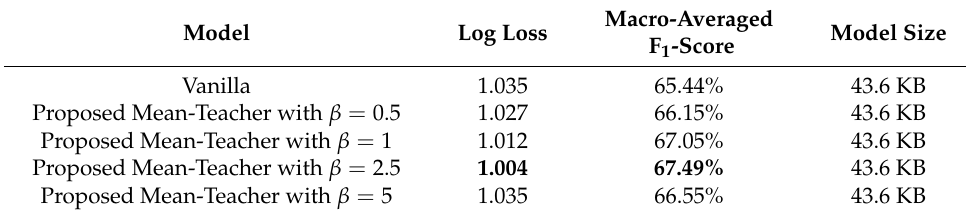
Table 8. Performances of the 1-bit-quantized WRN